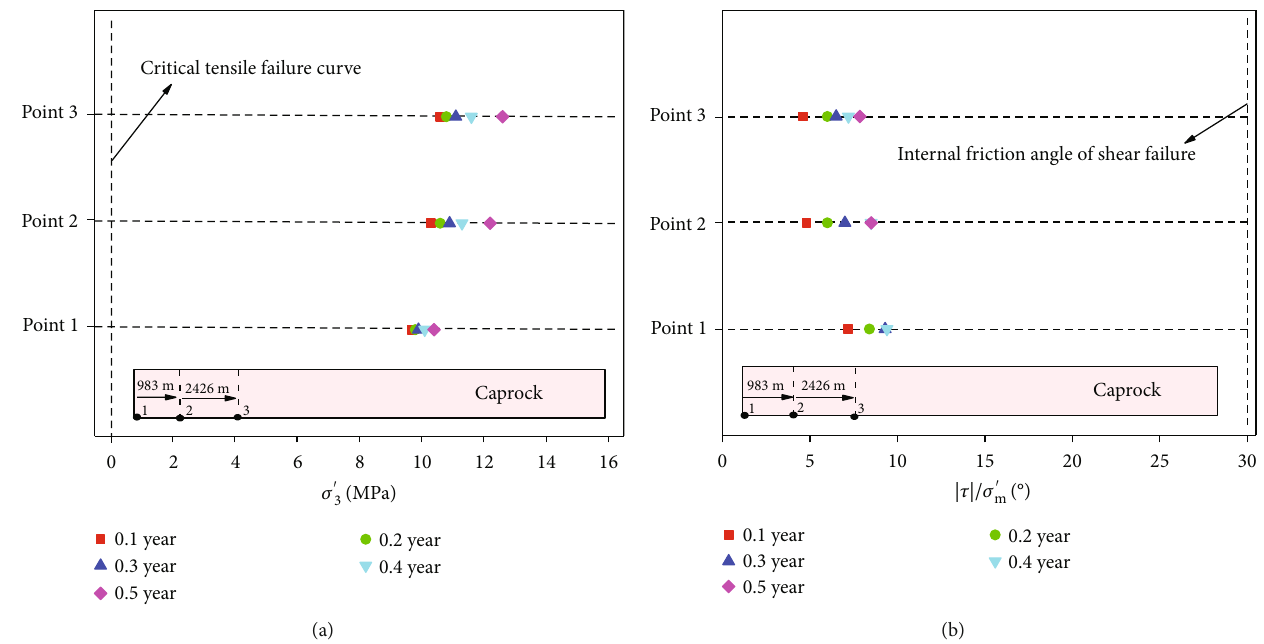
Figure 20: The in fl uence of injection rate on mechanical integrity of caprock. (a) The minimum principal stress. (b) Critical internal friction angle.